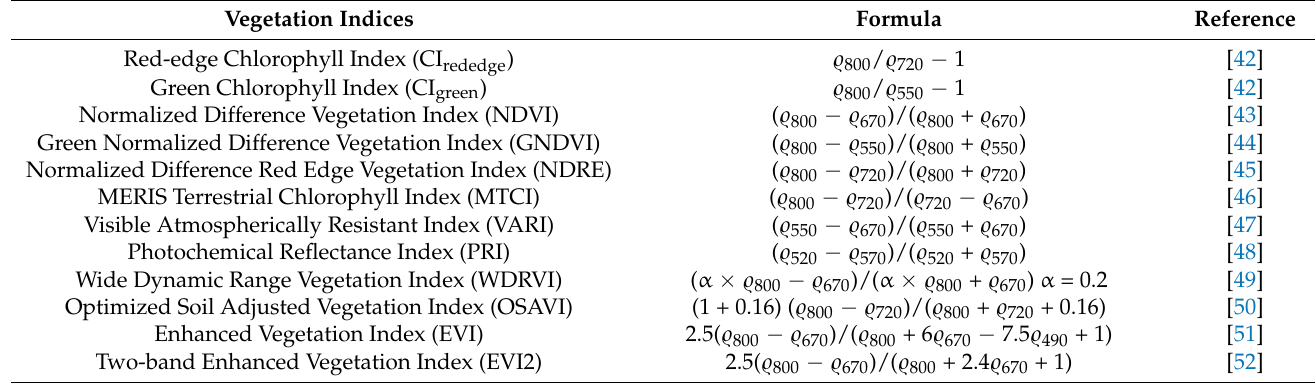
Table 1. Vegetation indices tested in this study.